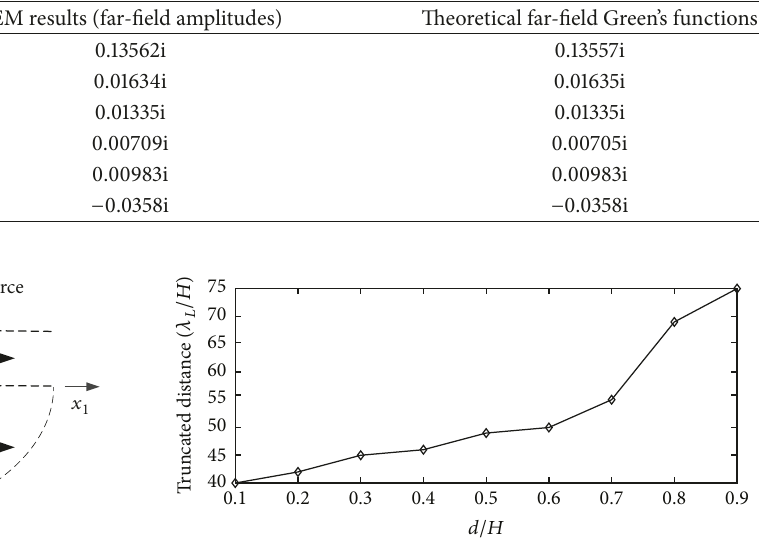
Table 1: Comparisons with truncated locations at 𝑥 = ±60𝜆 𝐿 /𝐻 ( 𝜆 𝐿 being the Love wavelength for the lowest mode) for the unit line source problem.